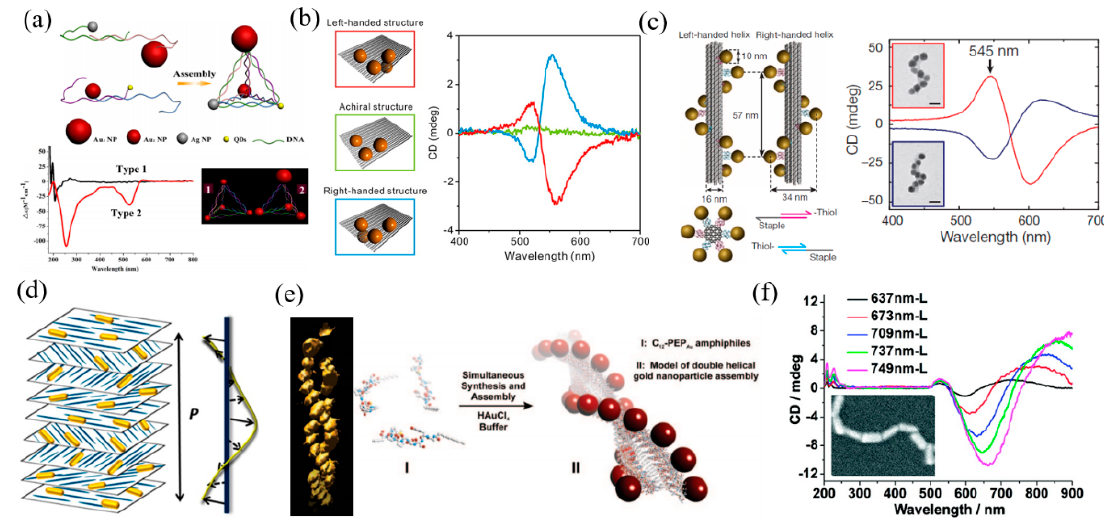
Figure 10. Nanostructures fabricated by bottom–up methods. ( a ) Schematic of chiral NP pyramids constructed by DNA scaffolds and their CD spectra. Adapted from [82], with permission from © 2012 American Chemical Society. ( b ) Four Au NPs assembled with an origami sheet with four docking sites. Three of the docking sites are along an L-shape on the one interface and one on the other. The NPs form left-handed, right-handed and achiral structure system and the corresponding CD spectra. Adapted from [85], with permission from © 2013 American Chemical Society. ( c ) Schematic of plasmonic nano helices with both left and right handedness based on of DNA self-assembly and the corresponding CD spectra. Adapted from [86], with permission from © 2012 Springer Nature. ( d ) Chiral gold NRs system synthesized by a layered, twisted cellulose nanocrystals template. Adapted from [87], with permission from © 2014 American Chemical Society. ( e ) Schematic of the formation of Au NP double helices, which are synthesized and assembled directly in a reaction containing HEPES buffer solutions of chloroauric acid and C 12 -PEP Au . Adapted from [89], with permission from © 2008 American Chemical Society. ( f ) SEM image of the one-dimensional (1D) self-assembled gold NRs (GNRs) and their CD spectra. Adapted from [90], with permission from © 2012 American Chemical Society.